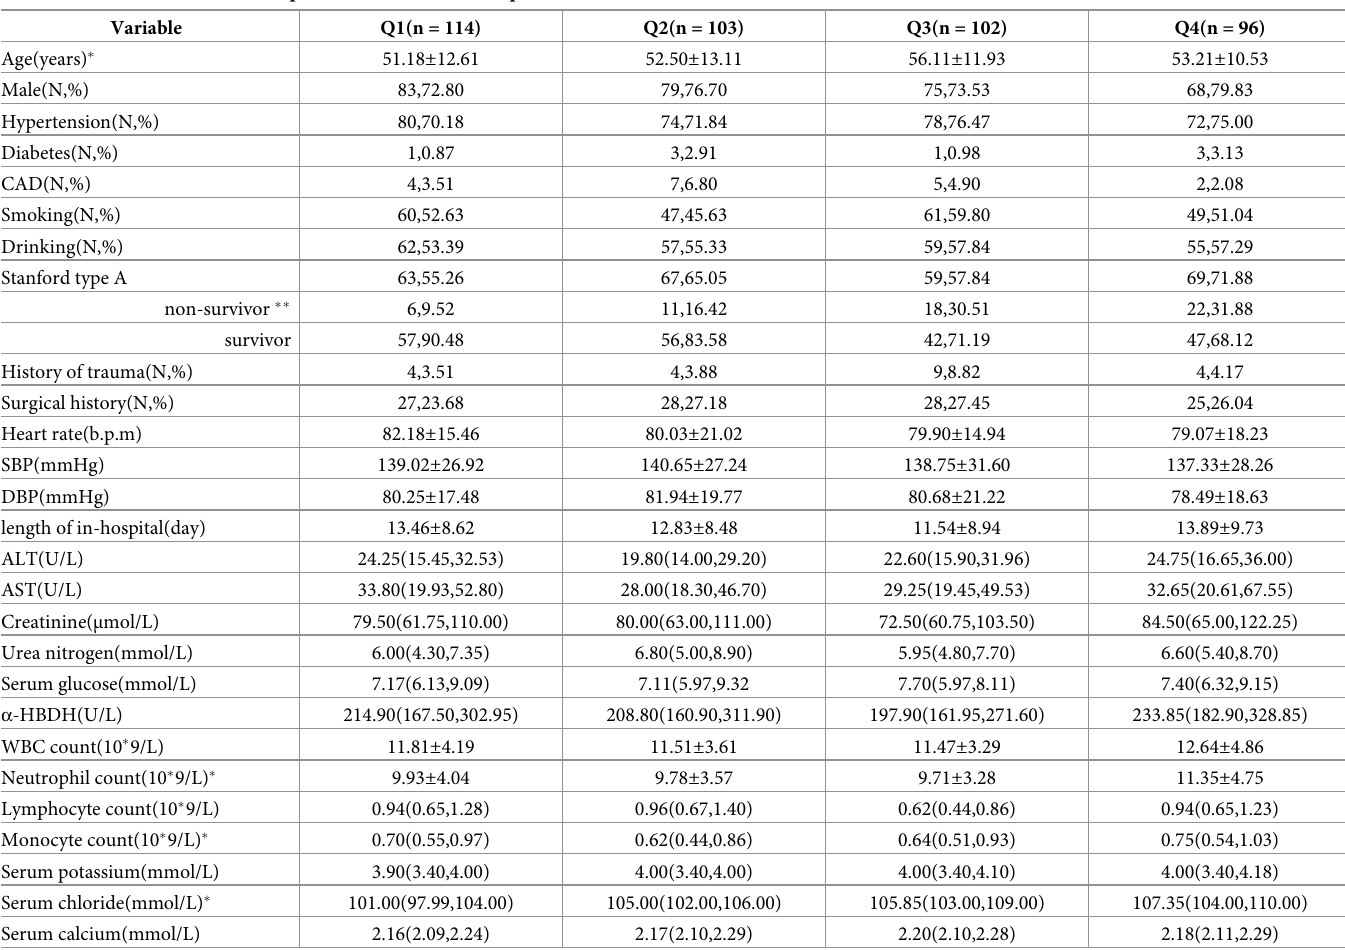
Table 2. Clinical characteristics of patients of serum sodium